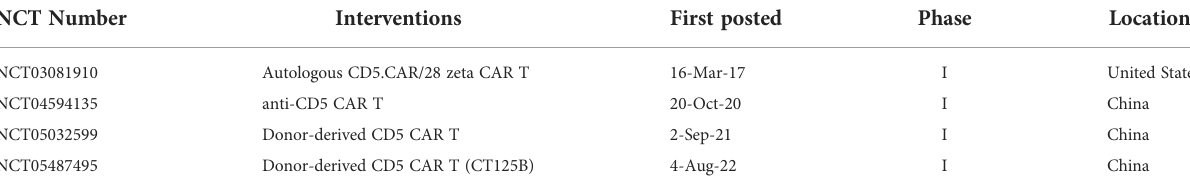
TABLE 1 Recruiting for CD5 CAR clinical